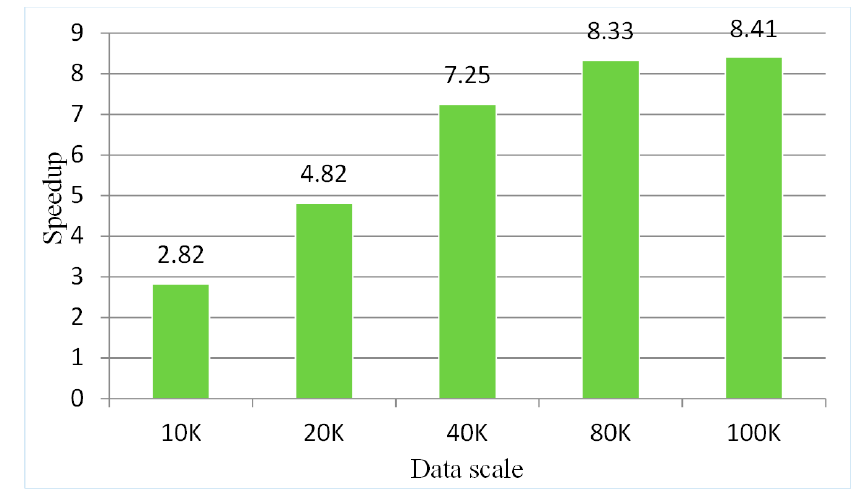
Figure 18. Speedup of the parallel DBSCAN algorithm based on a single-node Spark platform. 5.5.2. Testing the Optimized Parallel Algorithm on a Single-Node Spark Platform